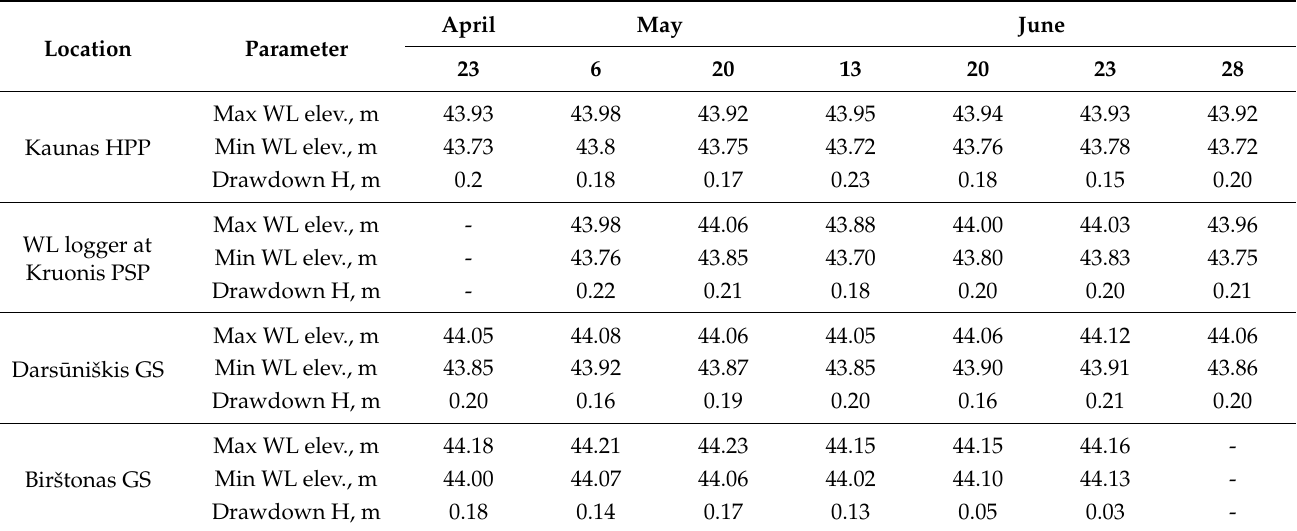
Table 3. Instances when the drawdown height limits were reached during the fish spawning period of